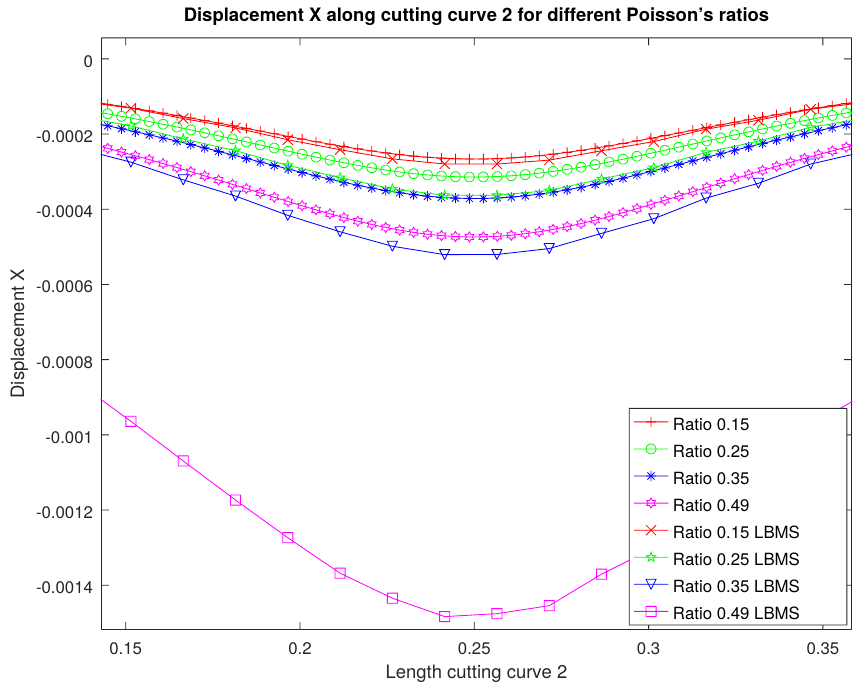
Figure A9. Detailed view of first displacement components along cutting curve C 2 for positive Poisson’s ratios.